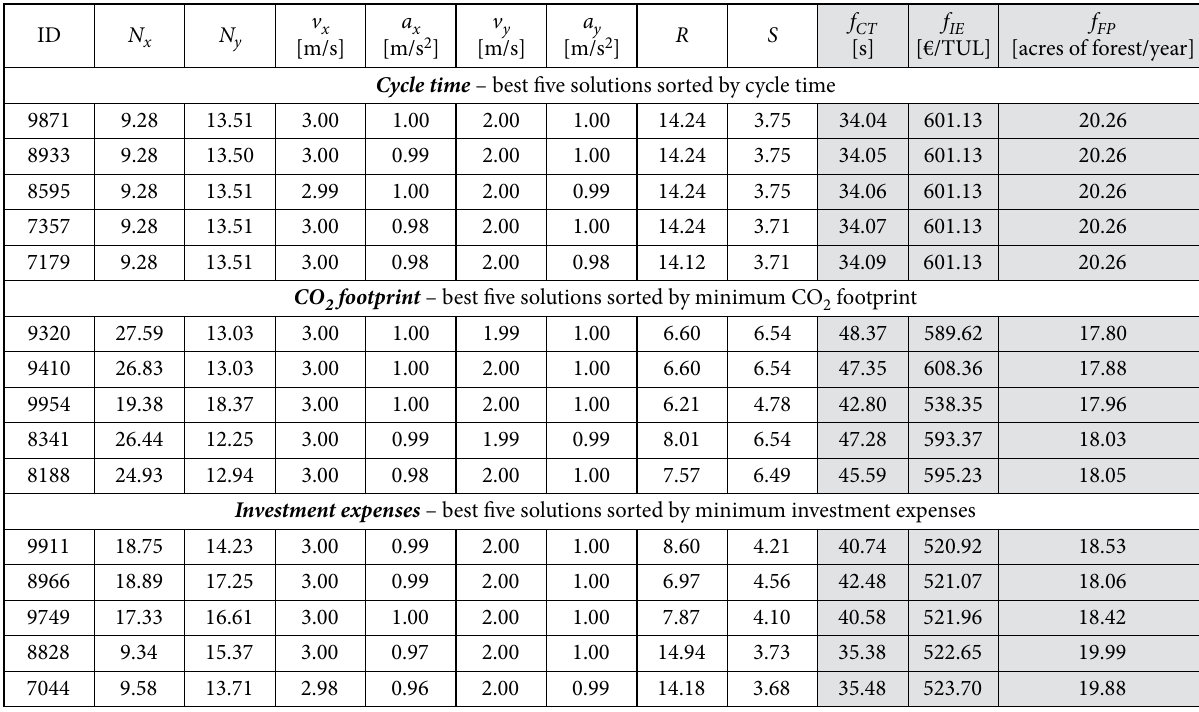
Figure 6. Results relation of minimal “cycle times” Figure 7. Results relation of minimal “CO 2 footprint” and minimal “investment expenses” and minimal “investment expenses” Table. Top 5 solutions for each objective function after